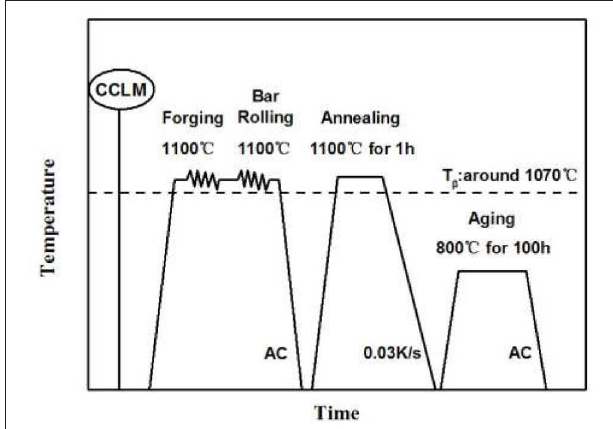
FIGURE 1 | A schematic diagram of the thermo-mechanical treatment for the Ti-25.5Al-13.5Nb-2.8Mo-1.8Fe alloy.